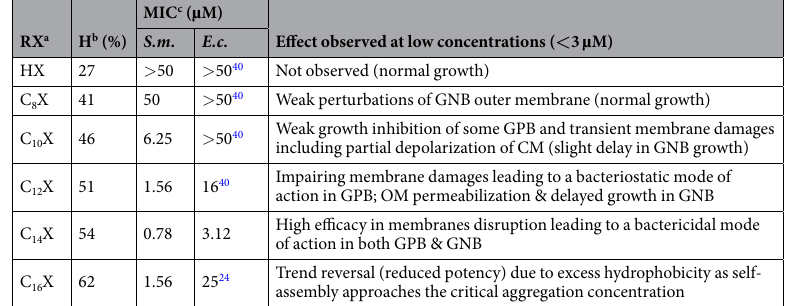
Table 2. Modulating biophysical properties of a core sequence by conjugating an N-terminal acyl. a R = N-terminal acyl, X = KKc b Hydrophobicity, defined as % acetonitrile eluent in C 12 K; c Minimal inhibitory concentration as determined by the microdilution method over S. mutans and E. coli representing GPB and GNB,